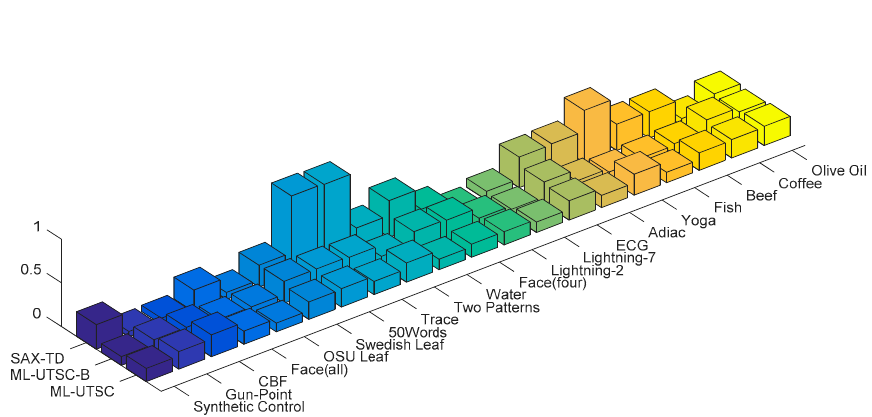
Figure 7. Comparison of dimension reduction for SAX-TD, ML-UTSC-B, and ML-UTSC.